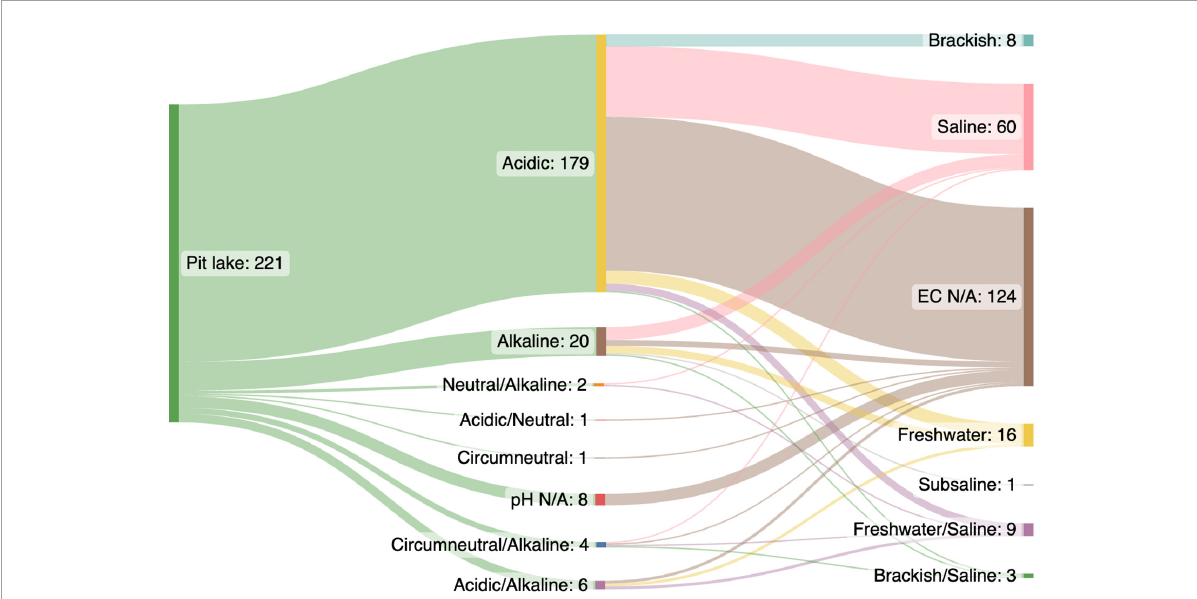
FIGURE1 Water quality (pH and conductivity) of 221 data points extracted from a Web of Science (WOS) literature search ( n = 128 papers) for research on pit lake microbiology ( Supplementary Table 1 ). Most data points ( n = 179) were extracted from acidic pit lakes (pH < 6.4) vs. circumneutral, neutral, and alkaline pit lakes (pH > 6.5; n = 27 data